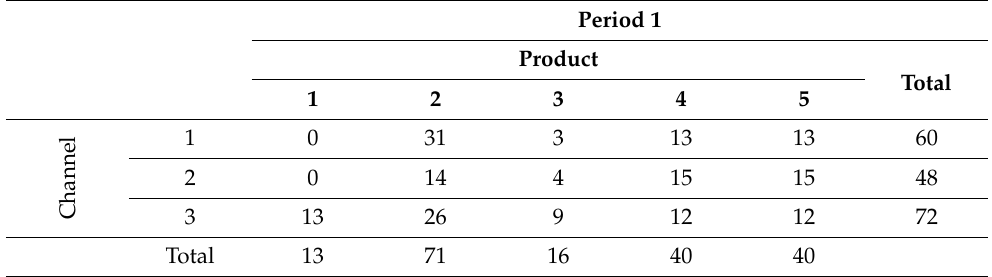
Table 3. Sales forecasting. Number of units of each product type for each channel during period